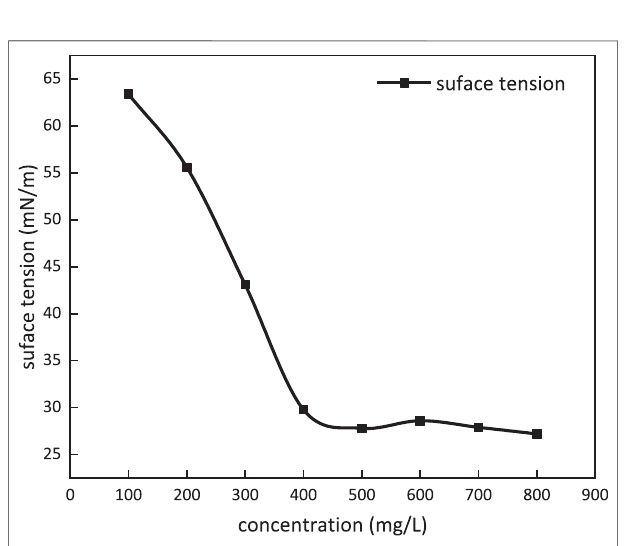
FIGURE 7 | FT-IR of HPAE and modi fi ed HPAE ( m -HPAE).